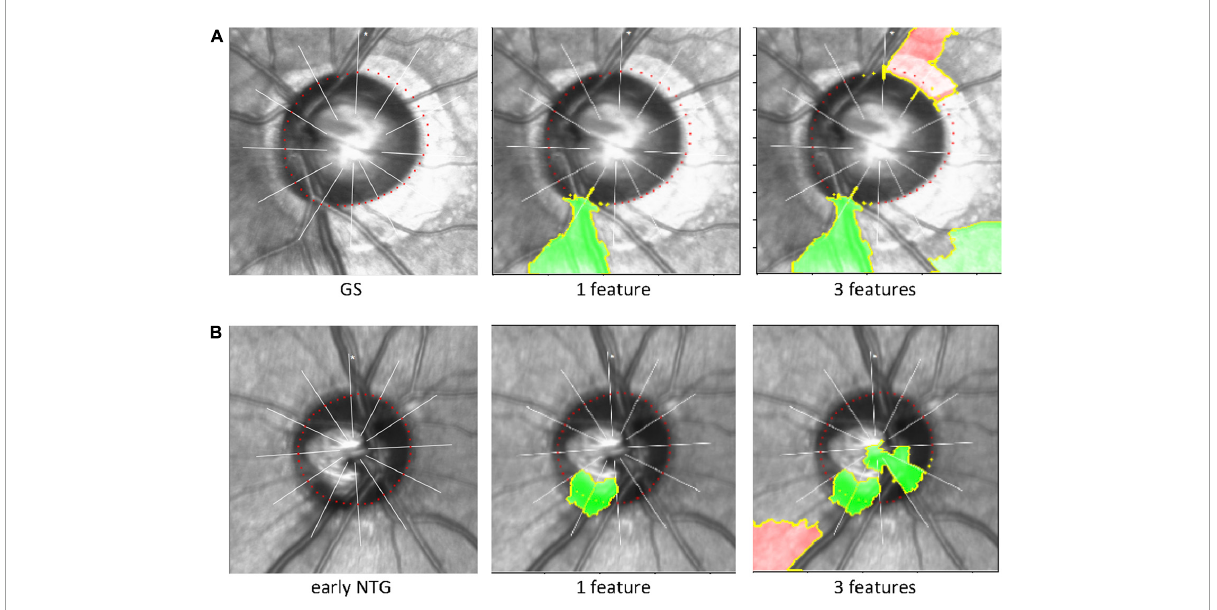
FIGURE4 Explainable artificial intelligence and Local Interpretable Model-agnostic Explanations. The LIME algorithm, a well-known technique of explainable AI explaining the predictions of black-box machine-learning models, was used to reveal the area of the image that our CNN model used to extract spatial and temporal features and predict its final classification of the diagnosis (i.e., GS or early NTG). The inferotemporal region of the cupping or neuroretinal rim in the optic disc was considered to be predominantly influential in classifying the final diagnosis. Representative cases are shown for GS and NTG. (A) For GS, our CNN model identified the inferotemporal region of the neuroretinal rim (green). (B) For early NTG, the inferotemporal region of the cupping and neuroretinal rim were identified for classification (green). Note that the region recognized by LIME (green) includes the BMO points (the red colored dotted line around the disc) in each region for classification of either early NTG or GS. AI: artificial intelligence; LIME: local interpretable model-agnostic explanations; GS: glaucoma suspect; NTG: normal-tension